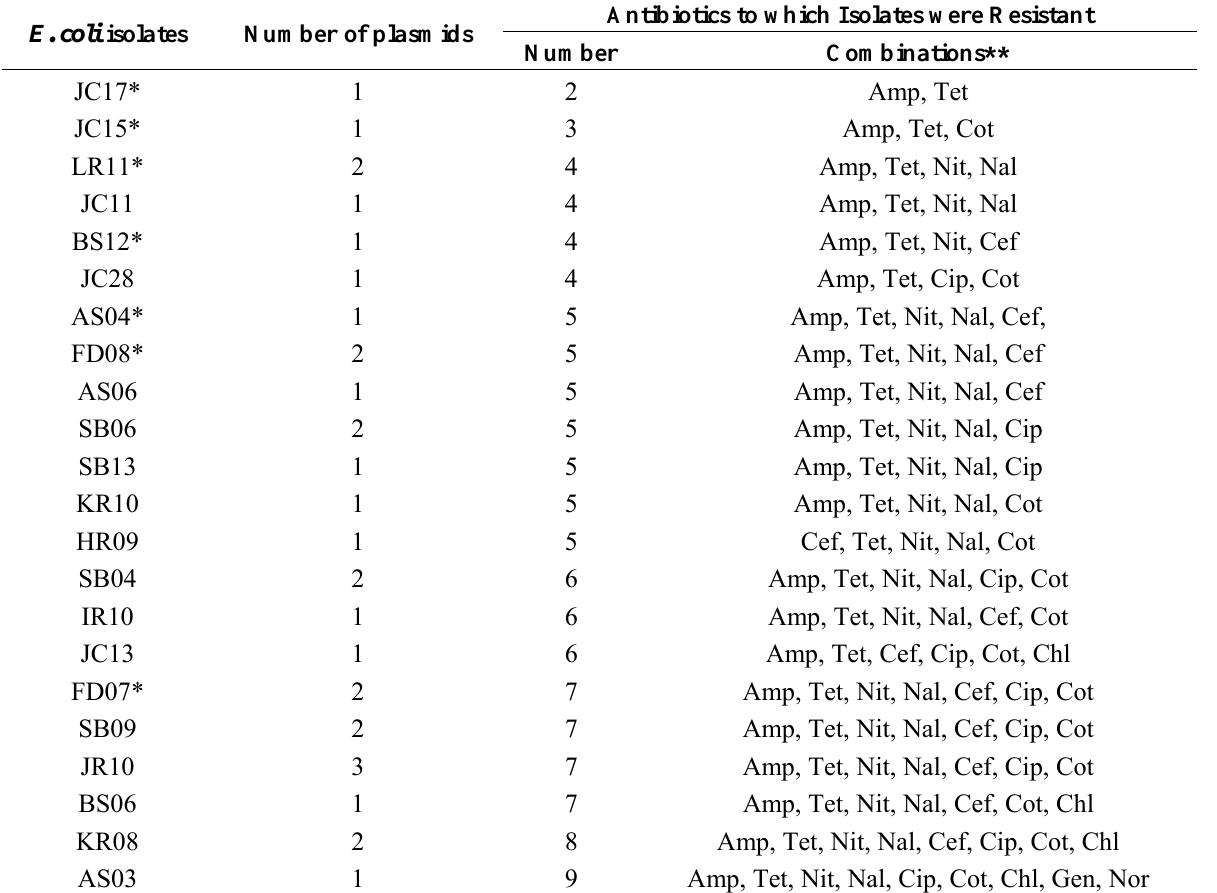
Table 5. Plasmid Profile and Multidrug Resistance Patterns of Plasmid-Containing E. coli Isolates. Antibiotics to which Isolates were Resistant E. coli isolates Number of plasmids Number